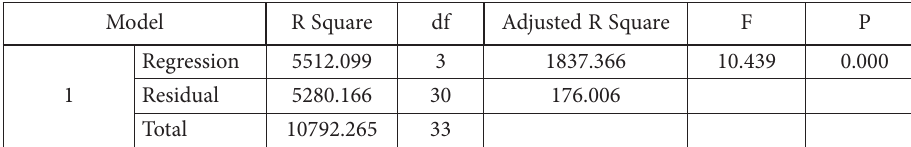
Table 9. ANOVA Regression Model Model